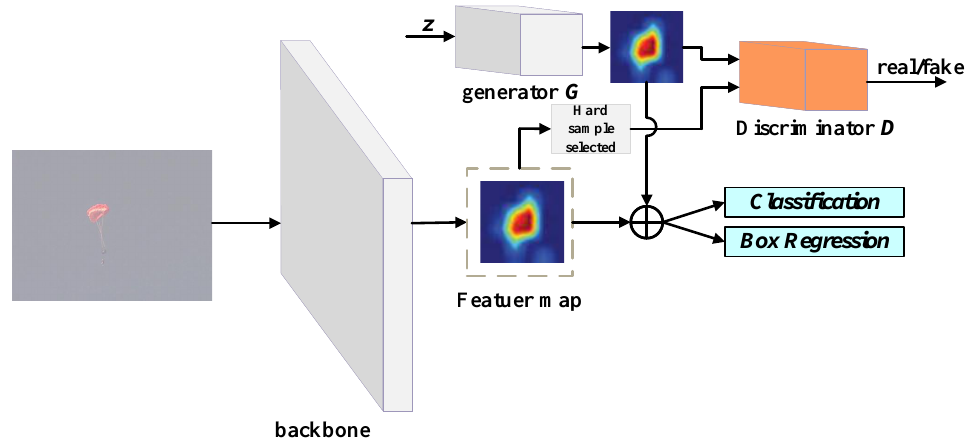
Figure 4. Overview of GANs-based object